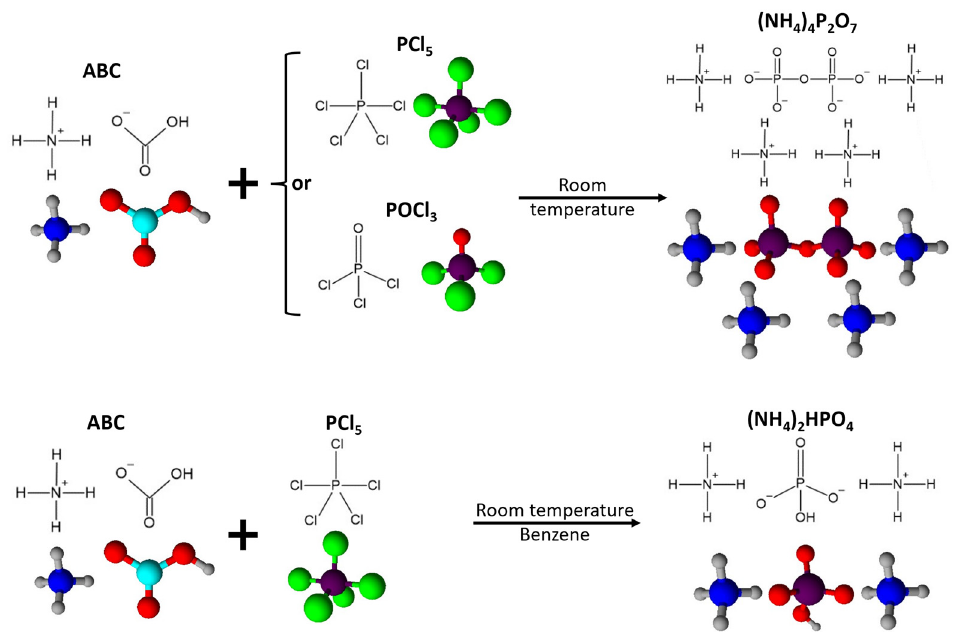
Figure 6. Alternative routes for ammonium bicarbonate conversion into N-P fertilizers. Compiled from [61].